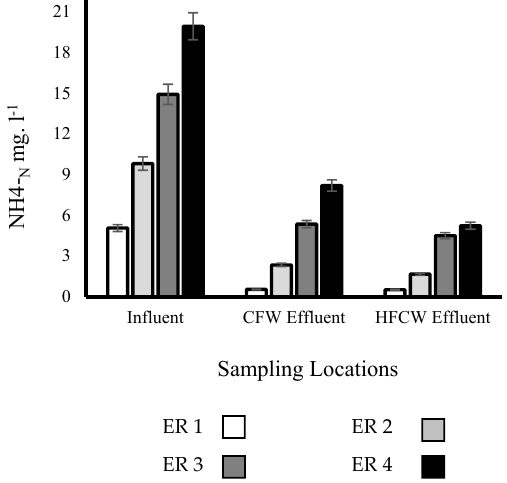
Figure 2. NH 4 –N concentration during different experimental runs in the second setup. Table 3. Estimated values of effluent during different ERs in Setups 1 and 2.